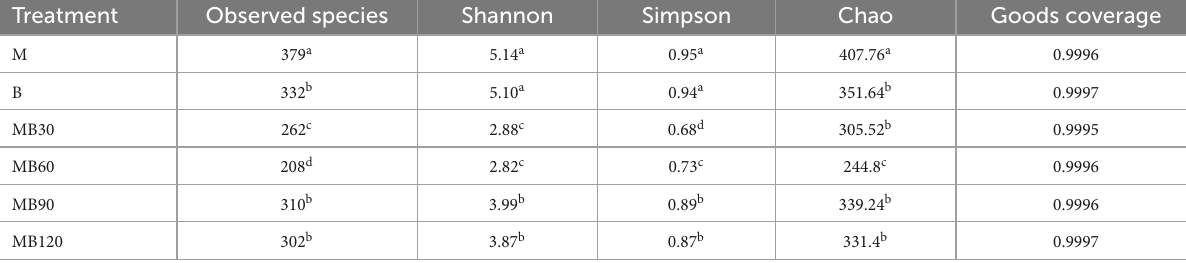
TABLE 4 Alpha-diversity of bacterial communities in fresh materials and after